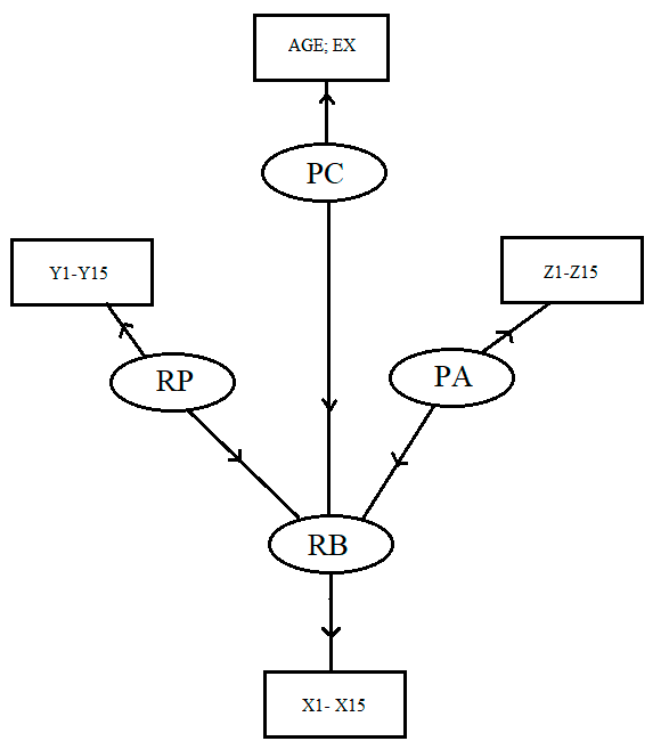
Figure 4. Relationship model of the study.